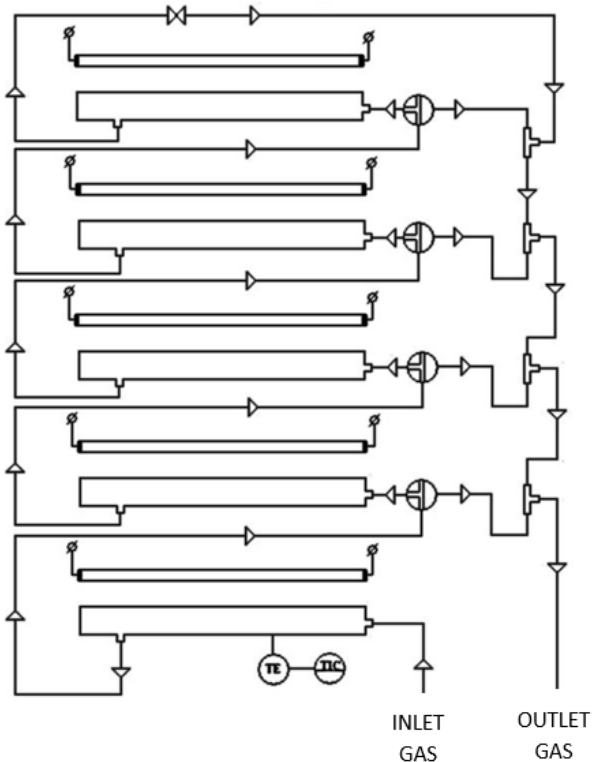
Figure 6. Schematic illustration of photocatalytic reactor: TIC: temperature indicator controller; TE:temperature element.